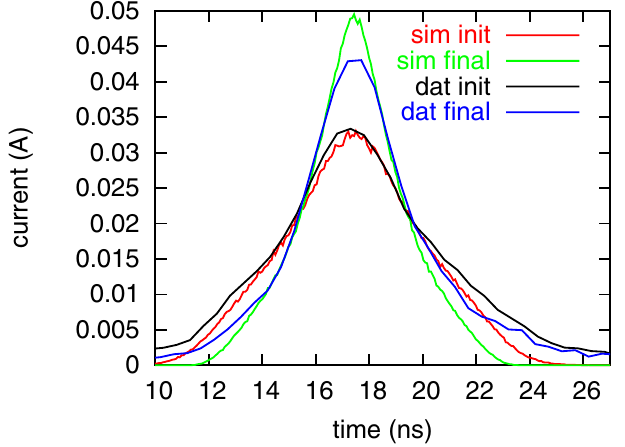
FIG. 11. (Color) Comparison of initial and final Schottky spec- tra at 4 GHz with simulations. The red and green lines are the simulated profiles before and after cooling, respectively. The black and blue lines are the experimental data before and after cooling, respectively. The simulations are offset by (cid:5) 20 dB for